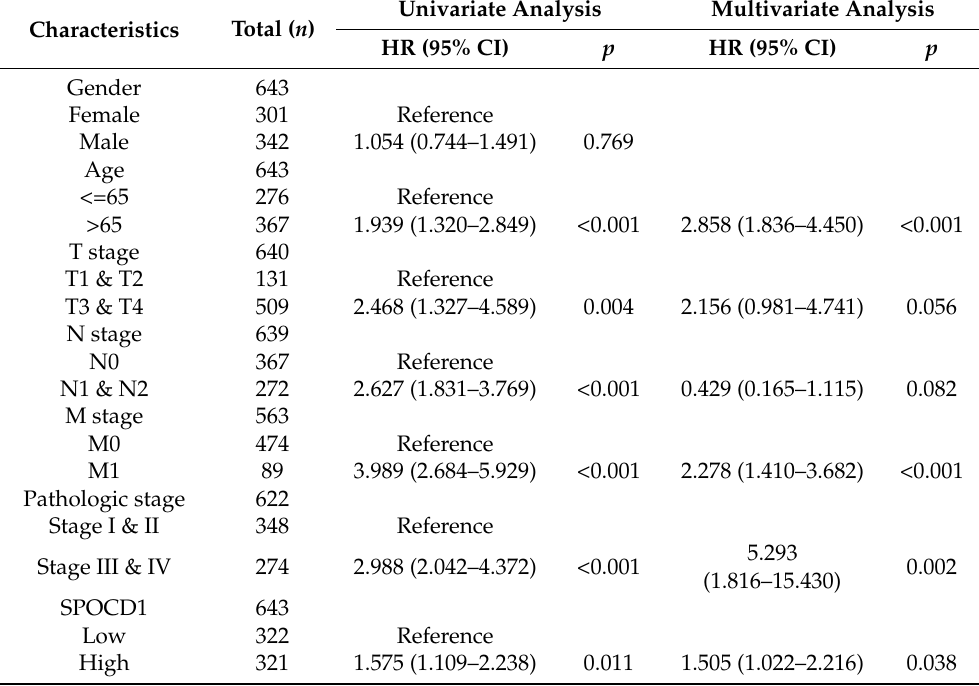
Table 2. The univariate and multivariate analysis of Overall Survival (OS).